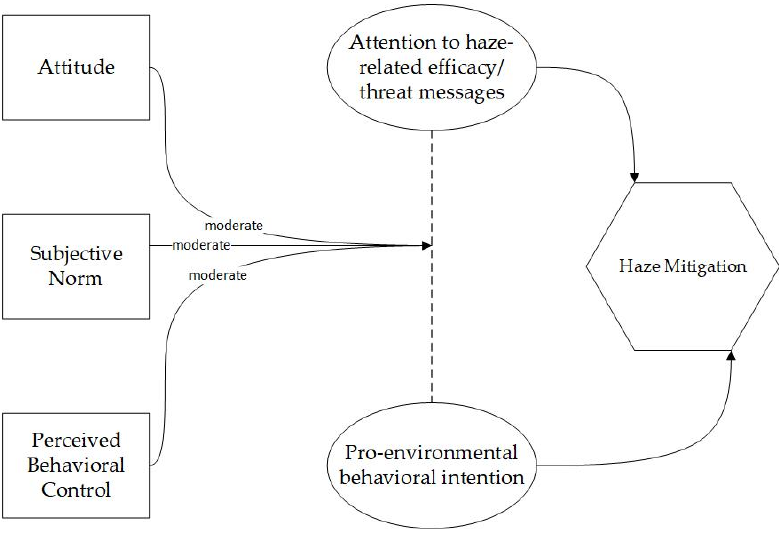
Figure 1. Conceptual model.